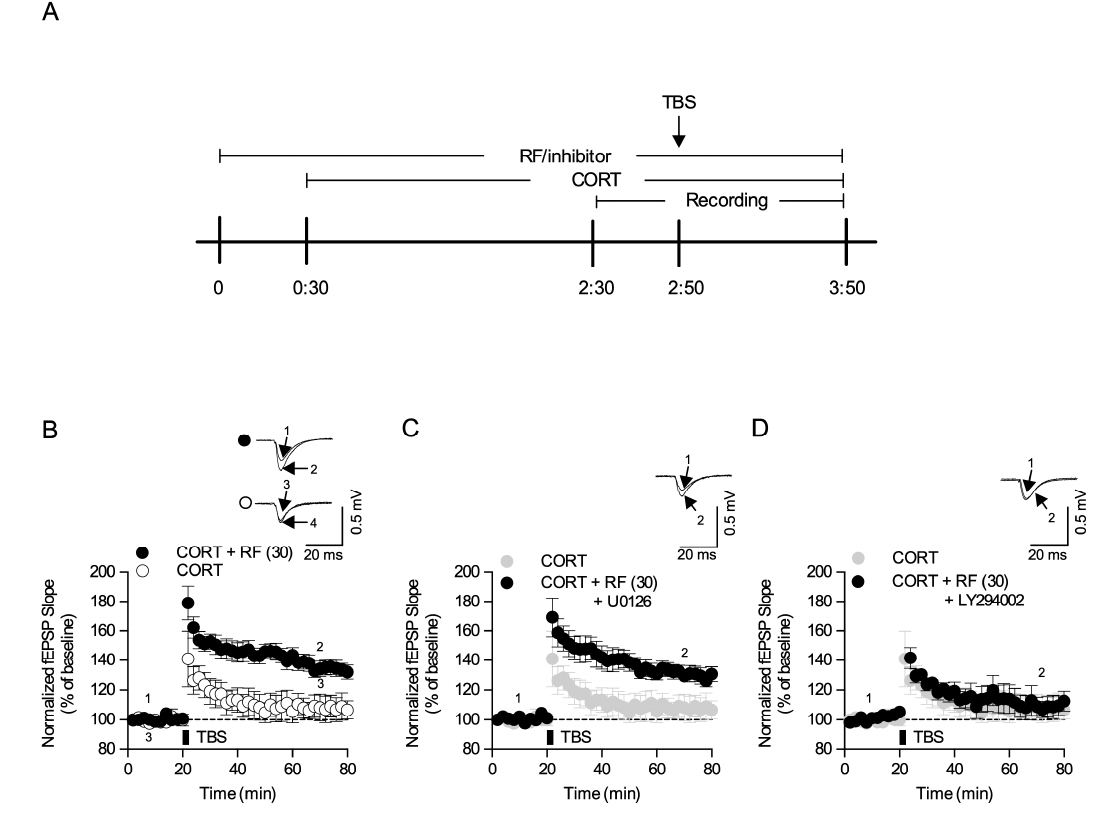
Figure 7. The role of Akt/GSK-3 β signaling in the effect of rubrofusarin synaptic deficit: ( A ) Hippocampal slices were co-treated with rubrofusarin (RF) and inhibitors. Corticosterone (1 µM, CORT) was introduced to the slices 30 min after RF treatment. Theta burst stimulation (TBS, 5 trains of 4 pulses at 100 Hz) was delivered to the slices 30 min after the CORT treatment. ( B ) Normalized fEPSP slop of CORT + RF (30 µM) and CORT group for 80 min. ( C ) Normalized fEPSP slop of CORT + RF (30 µM) + U0126 (50 µM) group for 80 min. ( D ) Normalized fEPSP slop of CORT + RF (30 µM) + LY294002 (50 µM) group for 80 min. Data represented as mean ± SD.